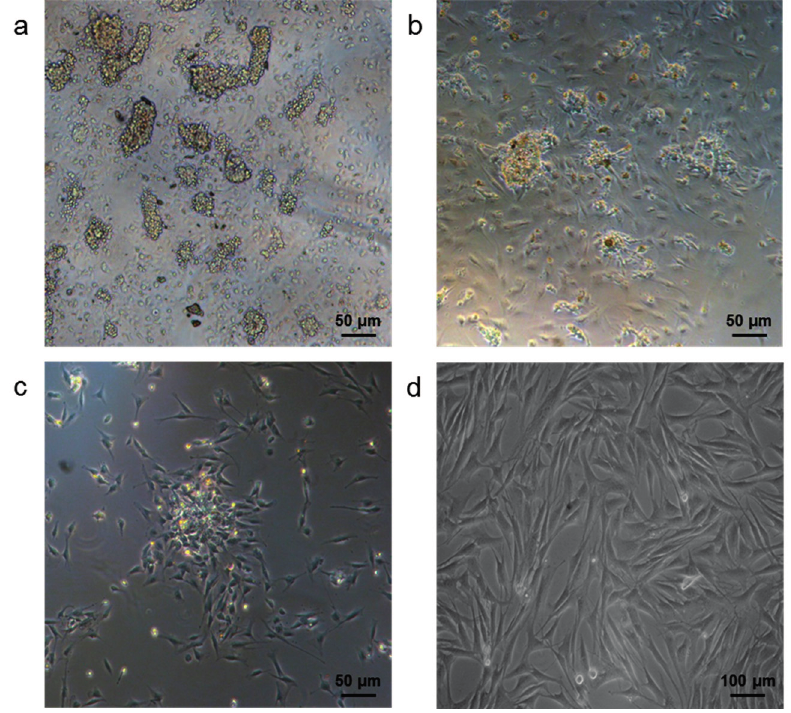
DPSCs acquired their final morphology: spindle-shaped and fibroblast-like (Figure 1d). Overall, the expanded DPSCs revealed a good proliferative potential and the ability to achieve confluence quickly.